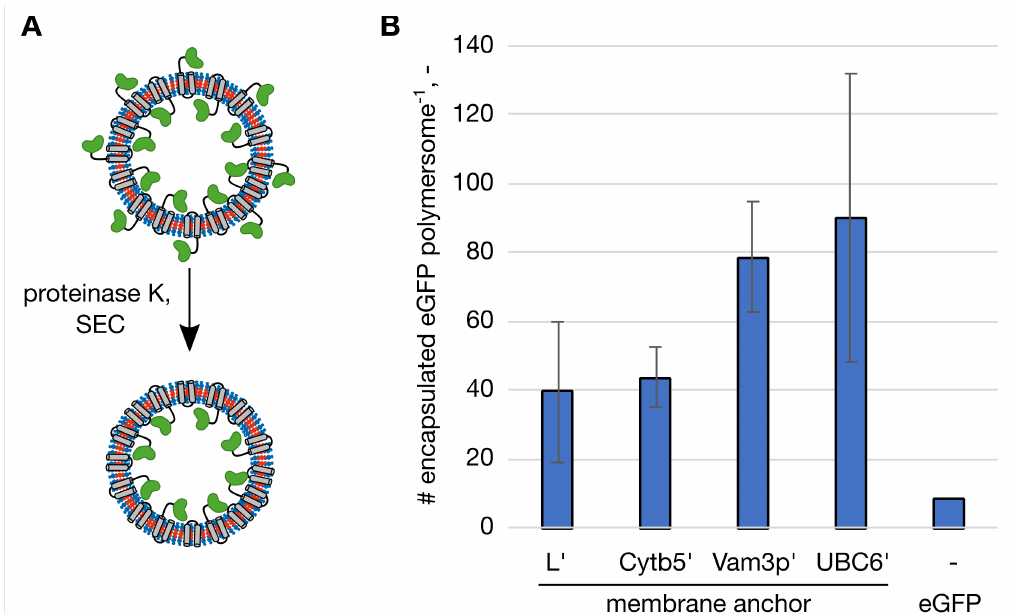
Figure 2. Maximal numbers of encapsulated enhanced green fluorescent protein (eGFP) molecules per polymersome with the respective membrane anchor and soluble eGFP without a membrane anchor as a control. ( A ) Polymersomes with membrane-anchoring eGFP were subjected to proteinase K digest and processed by size exclusion chromatography (SEC) to separate the polymersomes from the protein set free from the outer surface. The eGFP domains are shown in green, the membrane anchoring domains in grey. ( B ) Number (#) of encapsulated eGFP molecules per polymersome. Highest encapsulation was reached at different initial protein concentrations, L’: 0.75 g/L, Cytb5 (cid:48) : 0.78 g/L, Vam3p’: 0.30 g/L, UBC6 (cid:48) : 0.40 g/L and eGFP: 4.30 g/L. The standard deviation in technical triplicates is indicated by the error